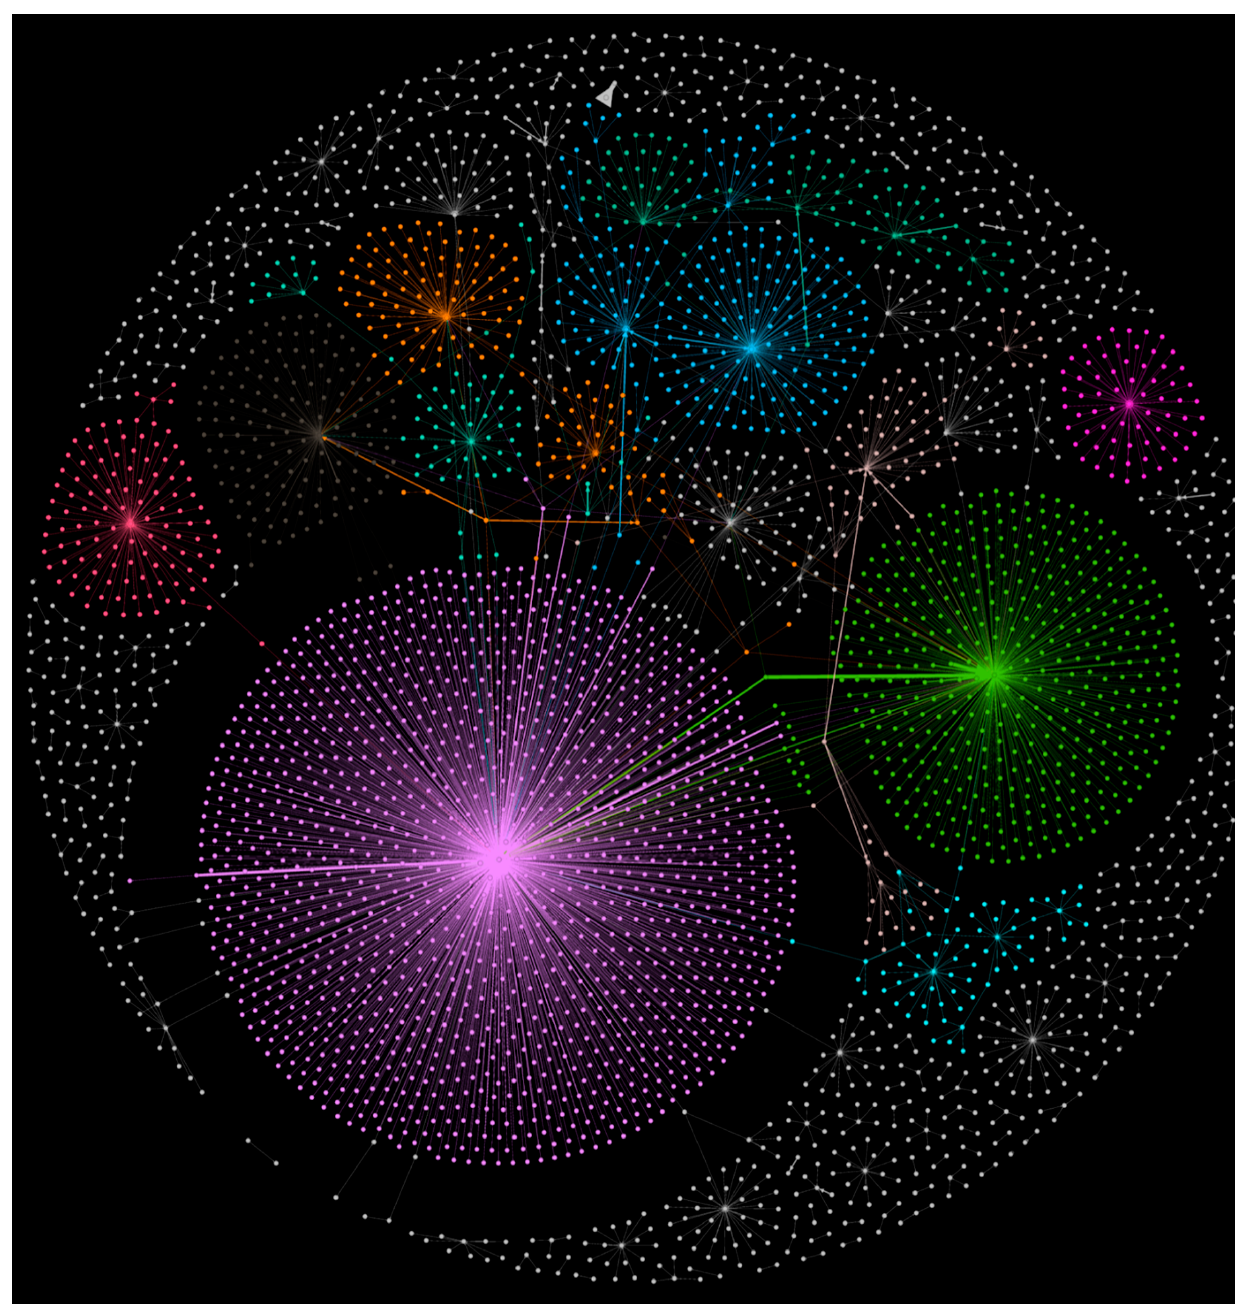
Figure 10. Fruchtenman Reingold Twitter retweets graph reveals the prominent role of CNN (in purple and light green) in redistribution and embracement of the Vatican’s announcement. Catholic news sources are at the top of the graph (blue and teal); communities from Brazil and the Philippines in top left.